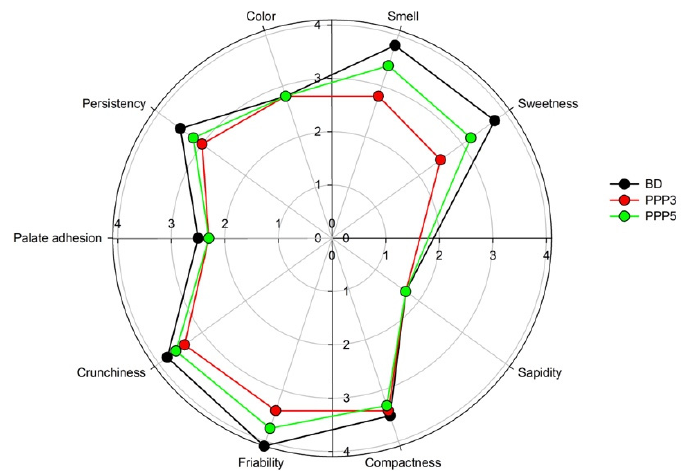
Figure 8. Blind panel results testing the sensory pleasantness of the biscuits prepared with the reference dough (BD) and the biscuits prepared with pomegranate peel powder at a concentration of 3 (PP3) and 5 (PPP5) wt%. The mean SD was ≤ 0.3.